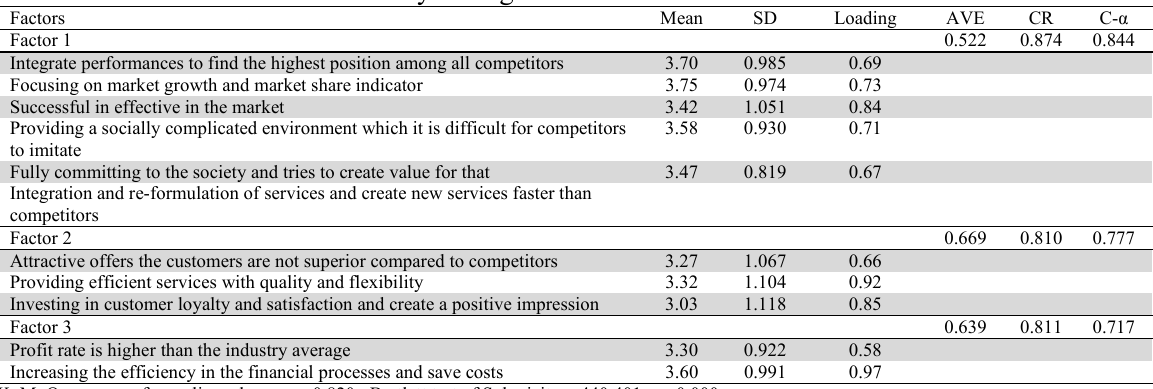
Results of CFA and internal reliability testing & K–M–O measure